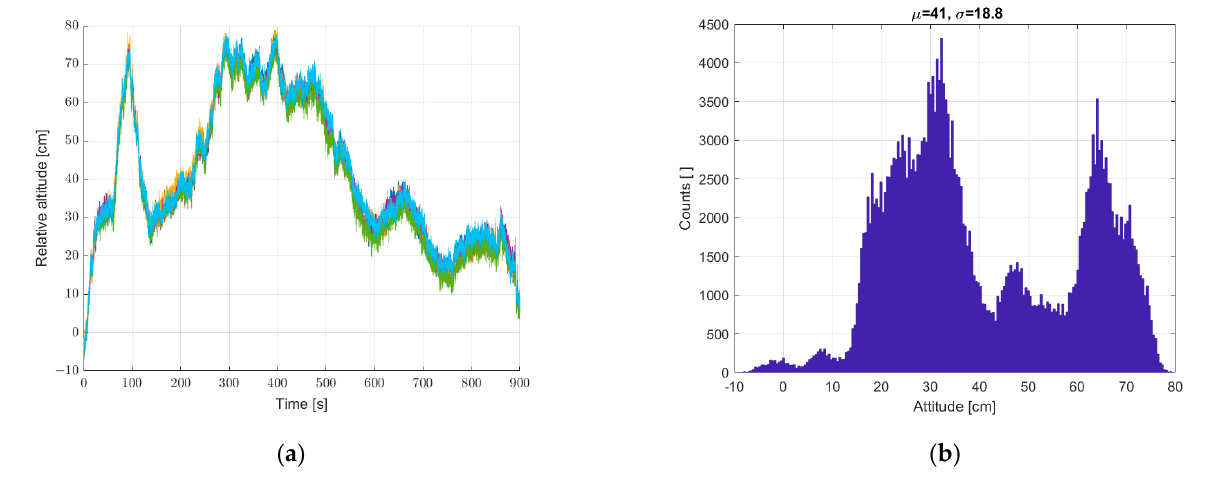
Figure 6. ( a ) Graph over time from six sensors without a reference sensor, and ( b ) histogram created from a single data vector merged from data vectors from six sensors. Static measurements—sensor array at standstill.